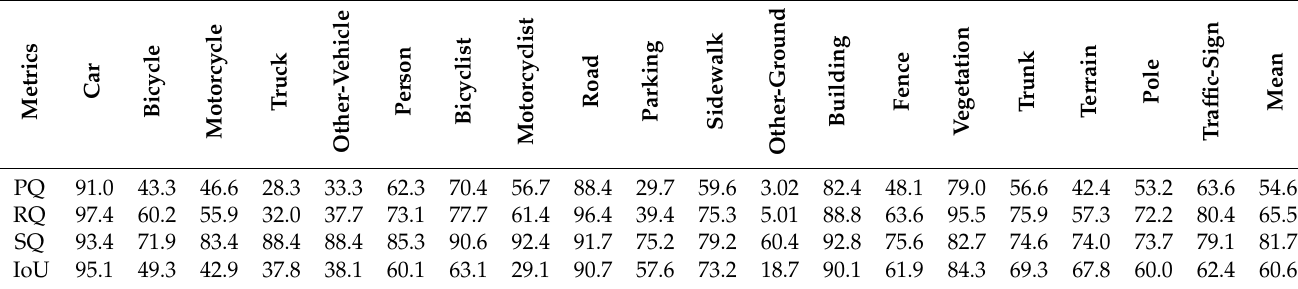
Table 3. Class-wise results on the test split of SemanticKITTI by our approach. Metrics are provided in